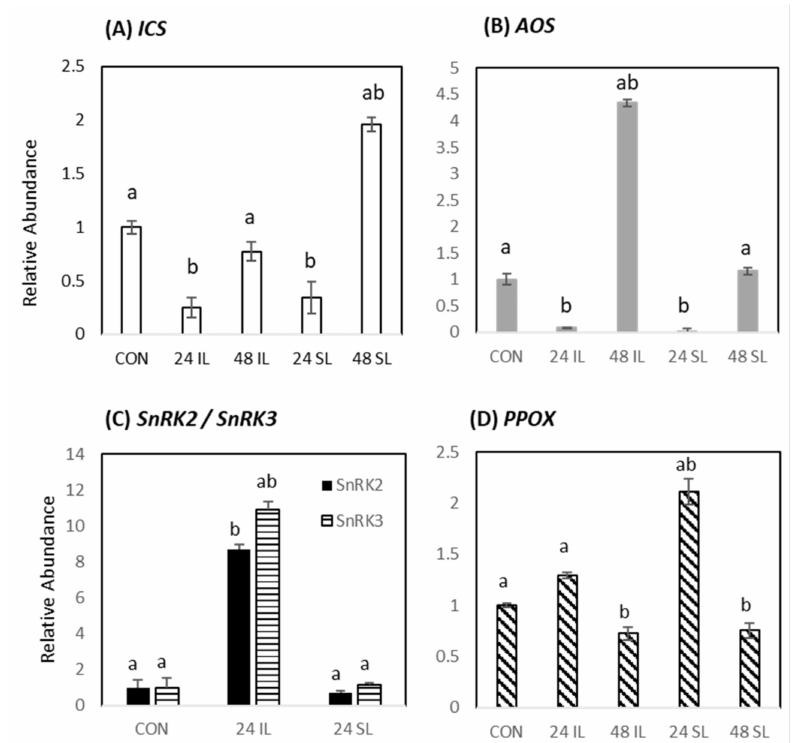
Figure 5. RT-qPCR assessment of key pathways suggested by metabolomic assessments of Black Pepper ( Piper nigrum L.) leaves challenged with Phytophthora capsici . Expression of ( A ) the salicylic acid biosynthetic gene— isochorismate synthase1 ( ICS1 ) ( B ) the jasmonate biosynthetic gene— allene oxide synthase ( AOS ), ( C ) the ABA-responsive snf1-related protein kinase 2 and 3 ( SnRK2 / SnRK3 ), ( D ) Vitamin B6 biosynthetic gene— pyridoxamine 5 (cid:48) -phosphate oxidase ( PPOX ) and in the leaf immedi- ately above the infection site (SL, systemic leaf) at 24 and 48 h after challenge and controls (CON). Statistical significance was determined by performing an ANOVA, statistically significant values ( p -value ≤ 0.05) were shown with different letters, whereas insignificance was labelled with the same